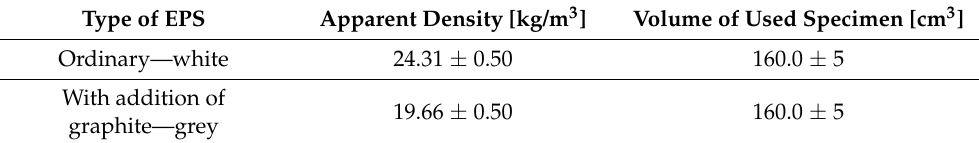
Table 1. Properties of EPS